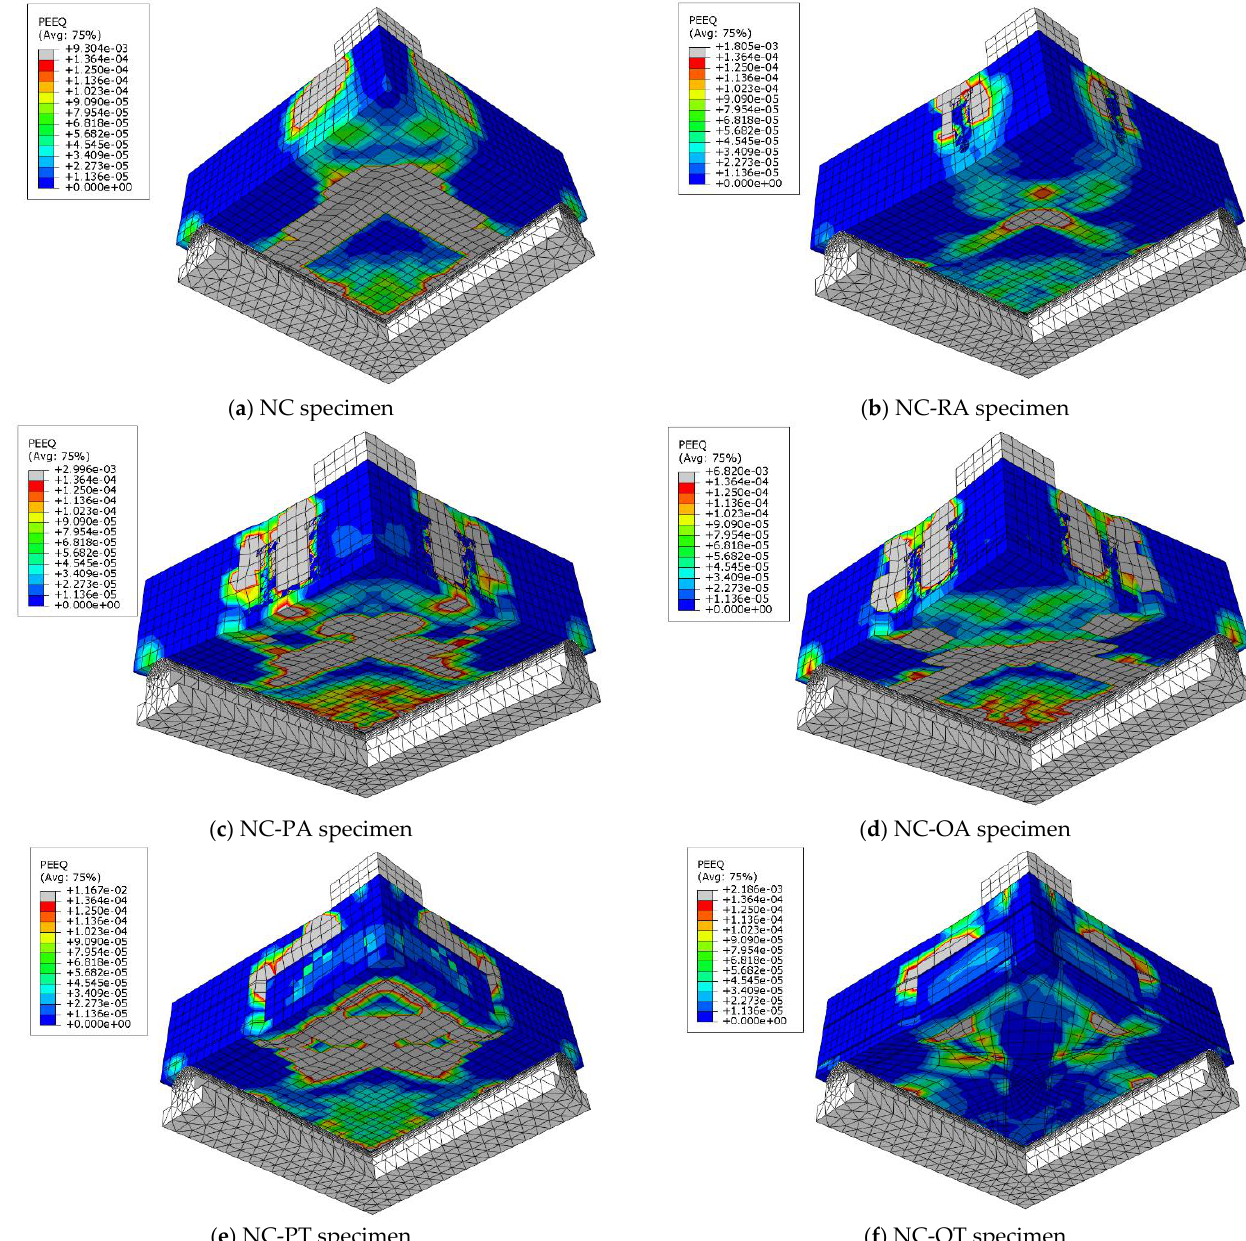
Figure 20. Numerical versus experimental load – displacement curves.